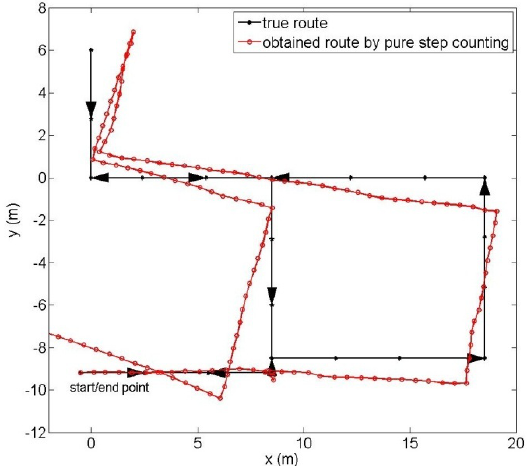
Figure 3. An example of localization results by pure step